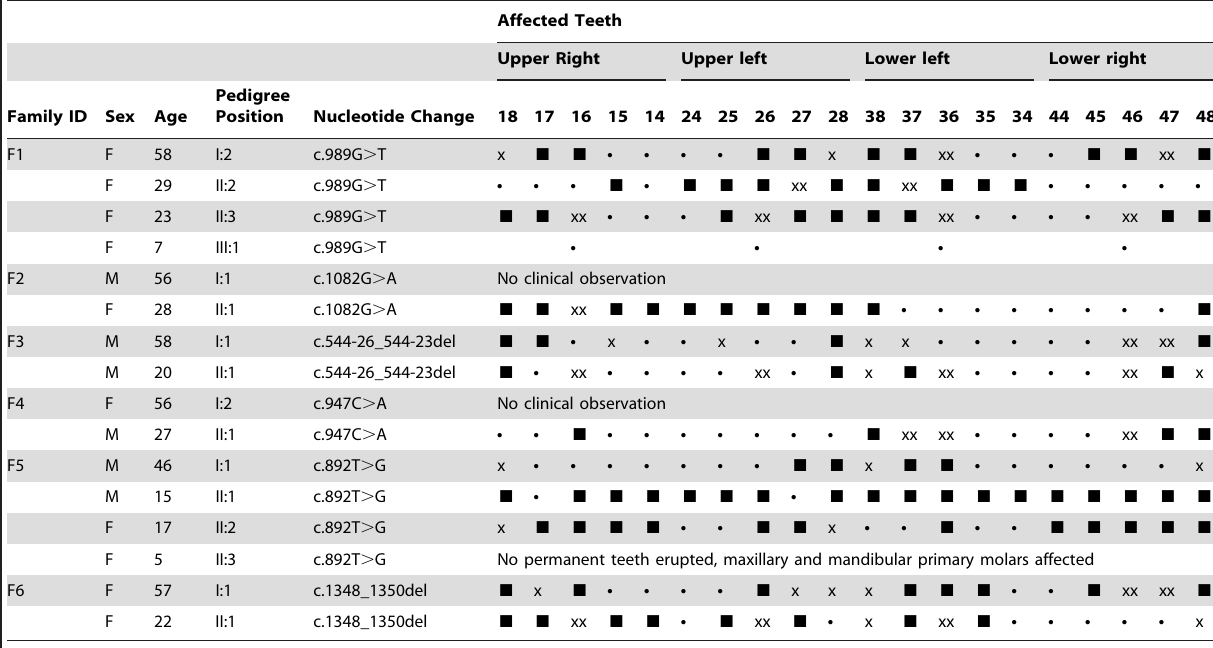
Affected Teeth Upper Right Upper left Lower right